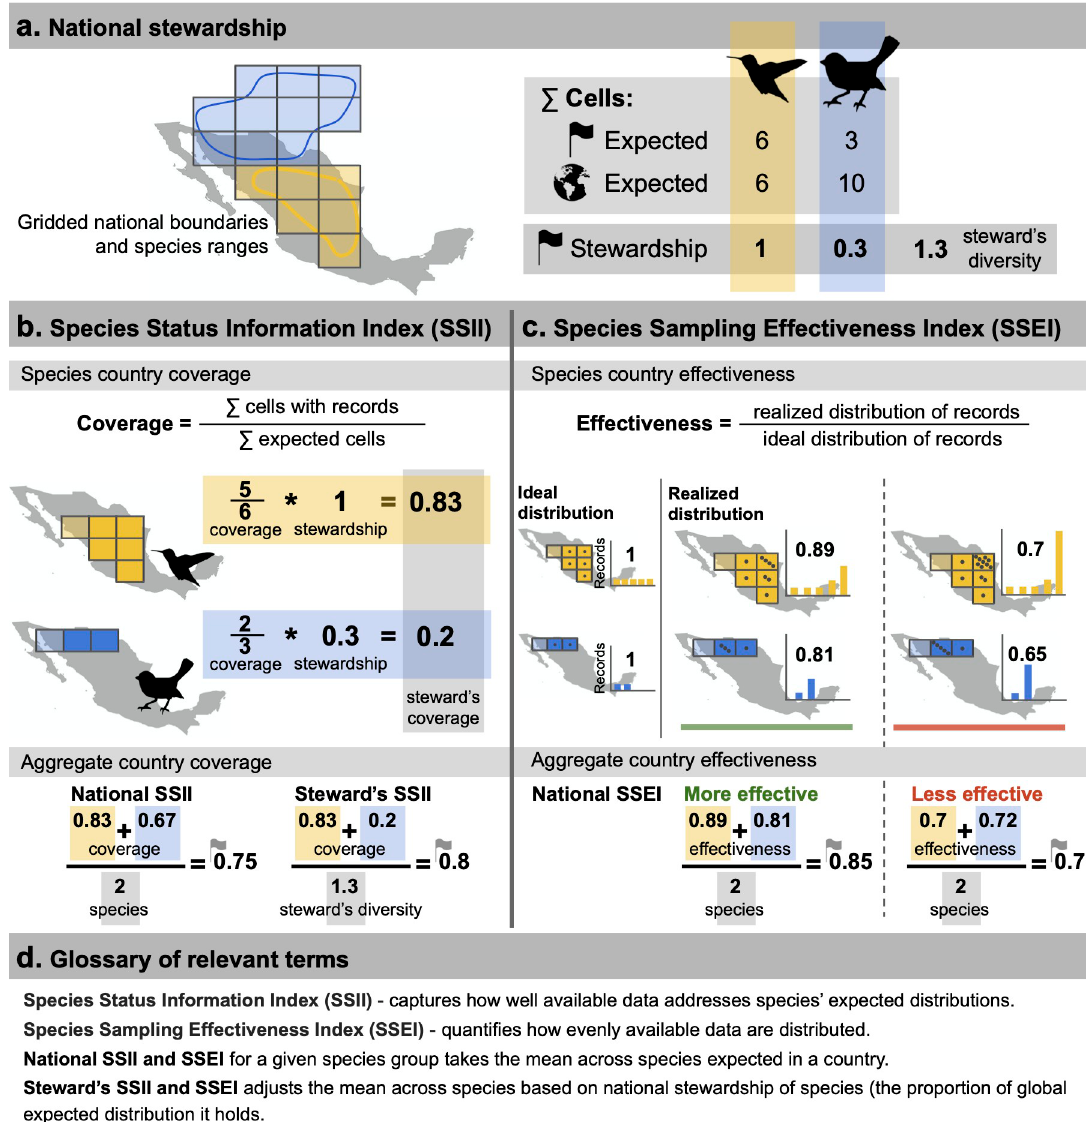
Fig 1. SSII and SSEI metrics of biodiversity data coverage and effectiveness. The metrics are illustrated for 2 hypothetical species with geographic range delineated by binary (e.g., expert range) maps and are assessed for an example 110-km equal-area grid. ( a) National stewardship of species is calculated based on the relative portion of species’ ranges falling inside a country. ( b) At the species level, the SSII is given as the proportion of cells expected occupied with records in a given year. In this hypothetical example, coverage is 0.83 and 0.67 for species where 5 out of 6 and 2 out 3 expected grid cells have data. Steward’s SSII adjusts this coverage by their respective national stewardship (0.83 and 0.2). Species-level SSII can be aggregated to the national level via 2 formulations. National SSII for a given taxonomic group takes the mean coverage across all species expected in a country (0.75). Steward’s SSII adjusts the mean coverage across species by their respective national stewardship (0.8). ( c) SSEI compares the entropy of the realized distribution of records to that of the ideal distribution (see Text A in S1 File), where uneven sampling (lower SSEI) is considered less effective than more even sampling (higher SSEI). National SSEI takes the mean across all species expected in a country. ( d) Glossary of relevant terms. Artwork from plylopics . org (see Text A in S1 File). GBIF AU : AbbreviationlistshavebeencompiledforthoseusedinFigs 1 (cid:0) 5 : Pleaseverifythatallentriesarecorrect : , Global Biodiversity Information Facility; MOL, Map of Life; SSEI, Species Sampling Effectiveness Index; SSII, Species Status Information Index.